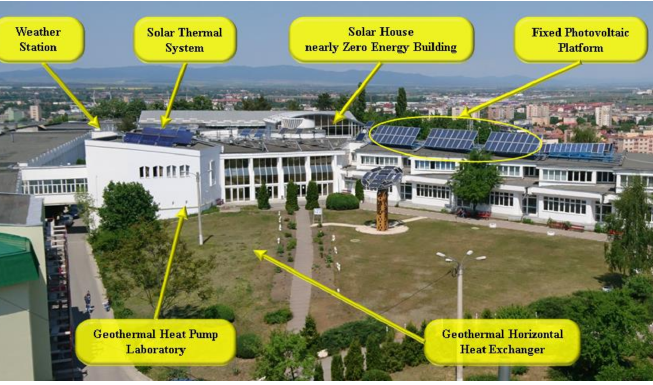
Figure 3. The Solar House and the renewable based energy mix installed on the Colina Hill Campus of the Transilvania University of Brasov,